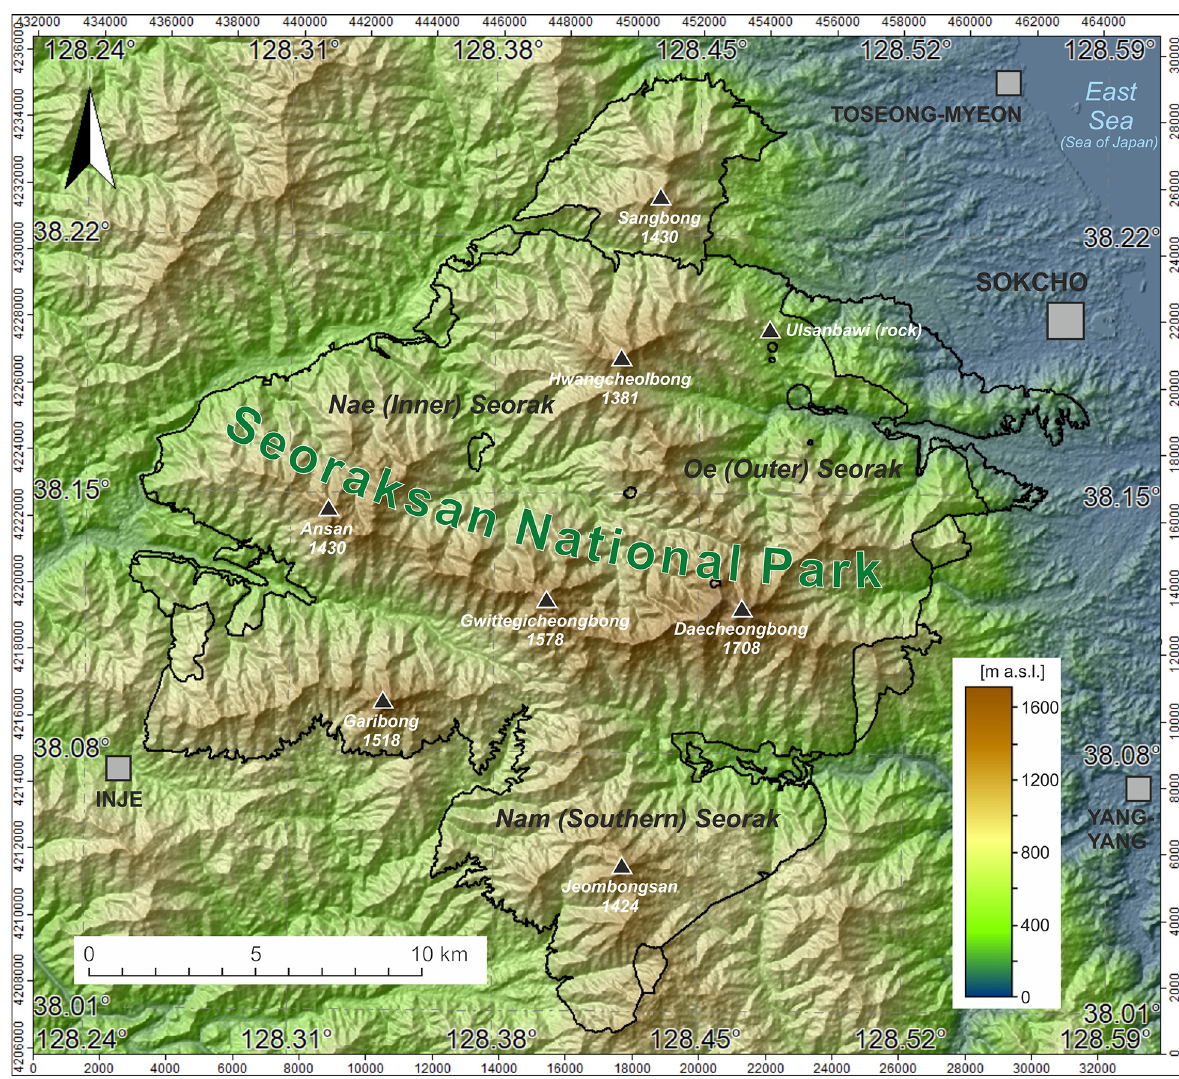
Fig. 3. general relief of Seoraksan and boundaries of the Seoraksan National Park. Source: USGS (2004), Shuttle Radar Topography Mission, 3 Arc Second scene